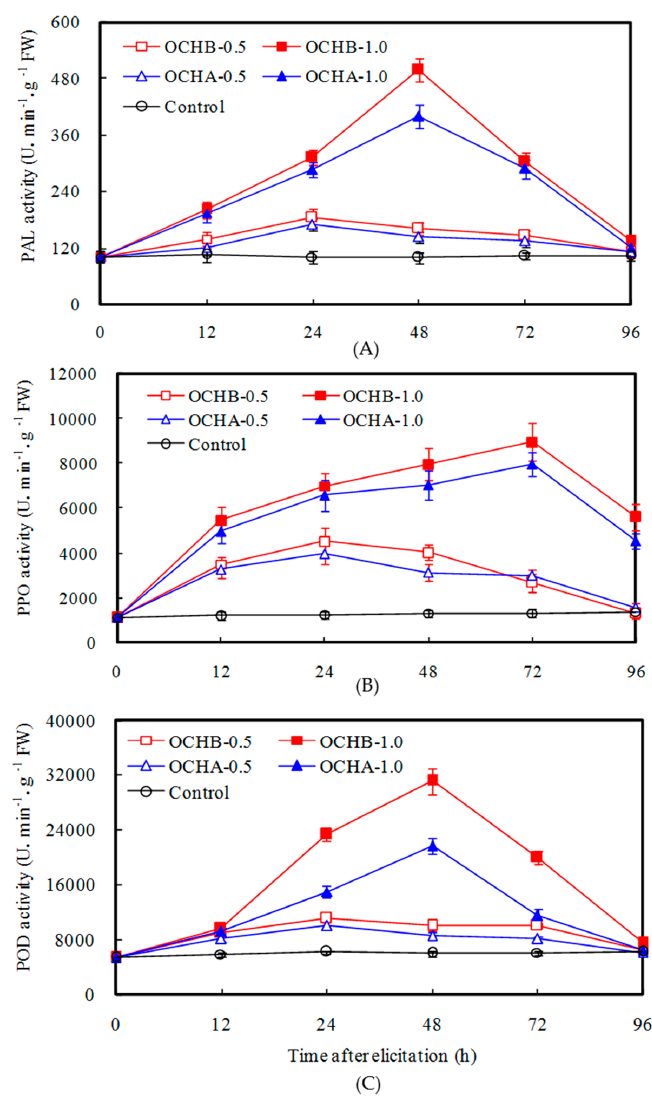
Figure 2. Effects of OCHA and OCHB on: PAL ( A ), PPO ( B ) and POD ( C ) activities in twigs of Z. bungeanum . The error bars represent standard deviations of the means from three independent samples; FW, fresh weight.